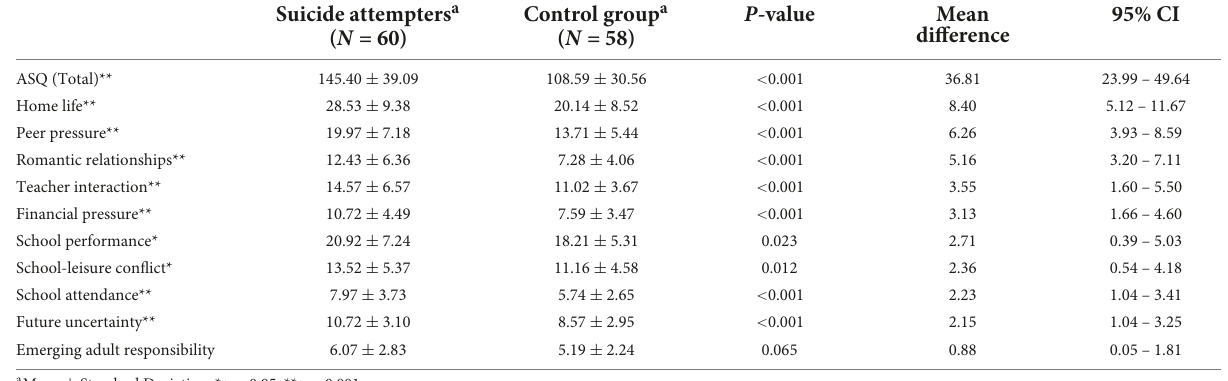
TABLE 3 Comparison of life stressors between suicide attempters and control group.